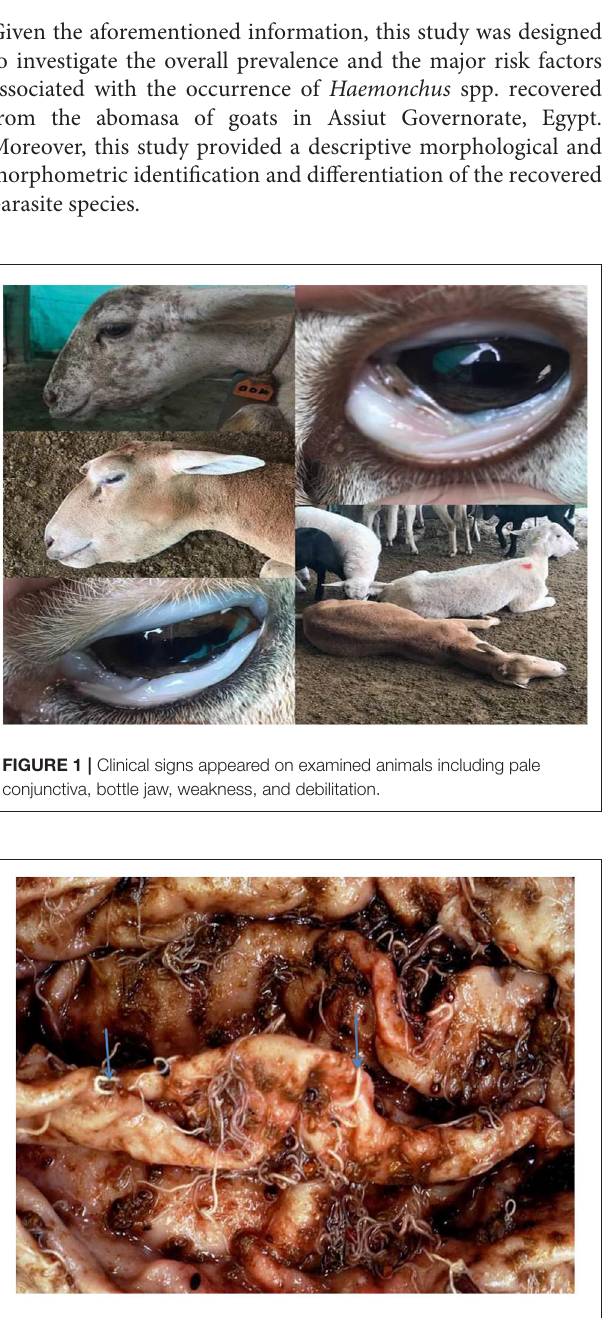
FIGURE 2 | Macroscopic appearance of abomasa following postmortem examination with adult